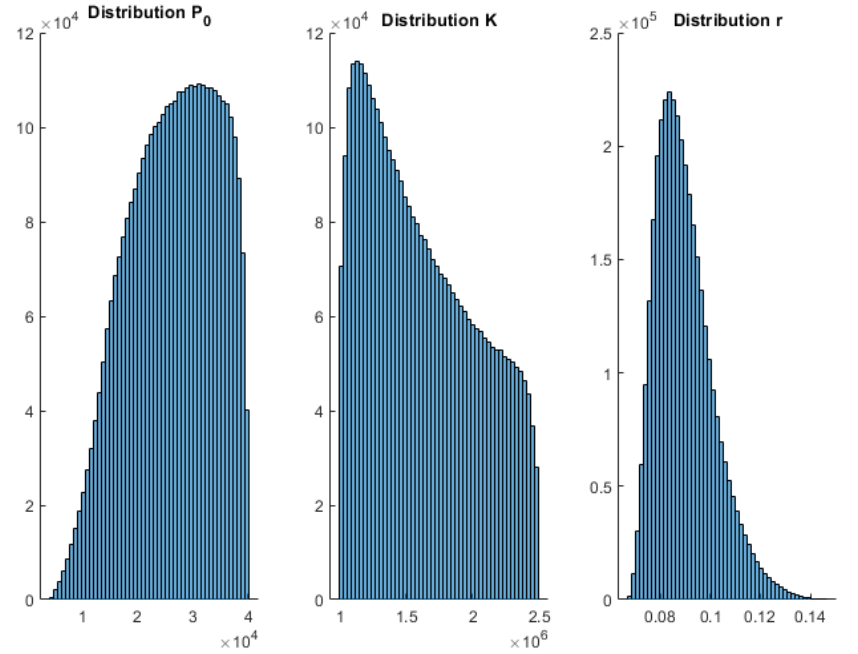
Figure A4. Histograms 25 January 2021 wave 3 Verhults—Spain.